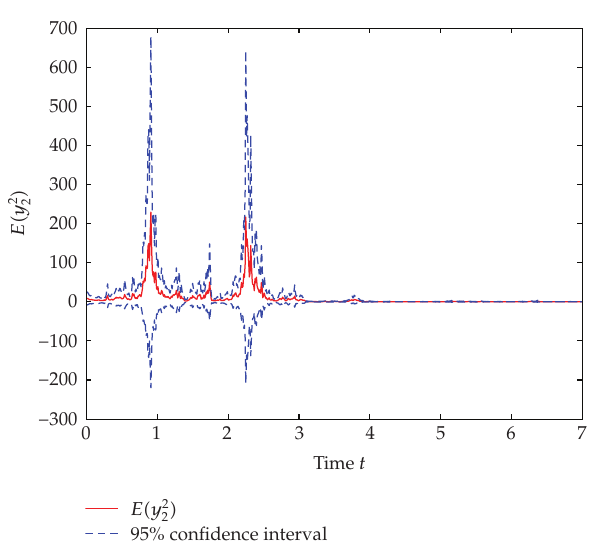
Figure 4: Numerical simulation for the mean square of y 2 (cid:3) t (cid:4)